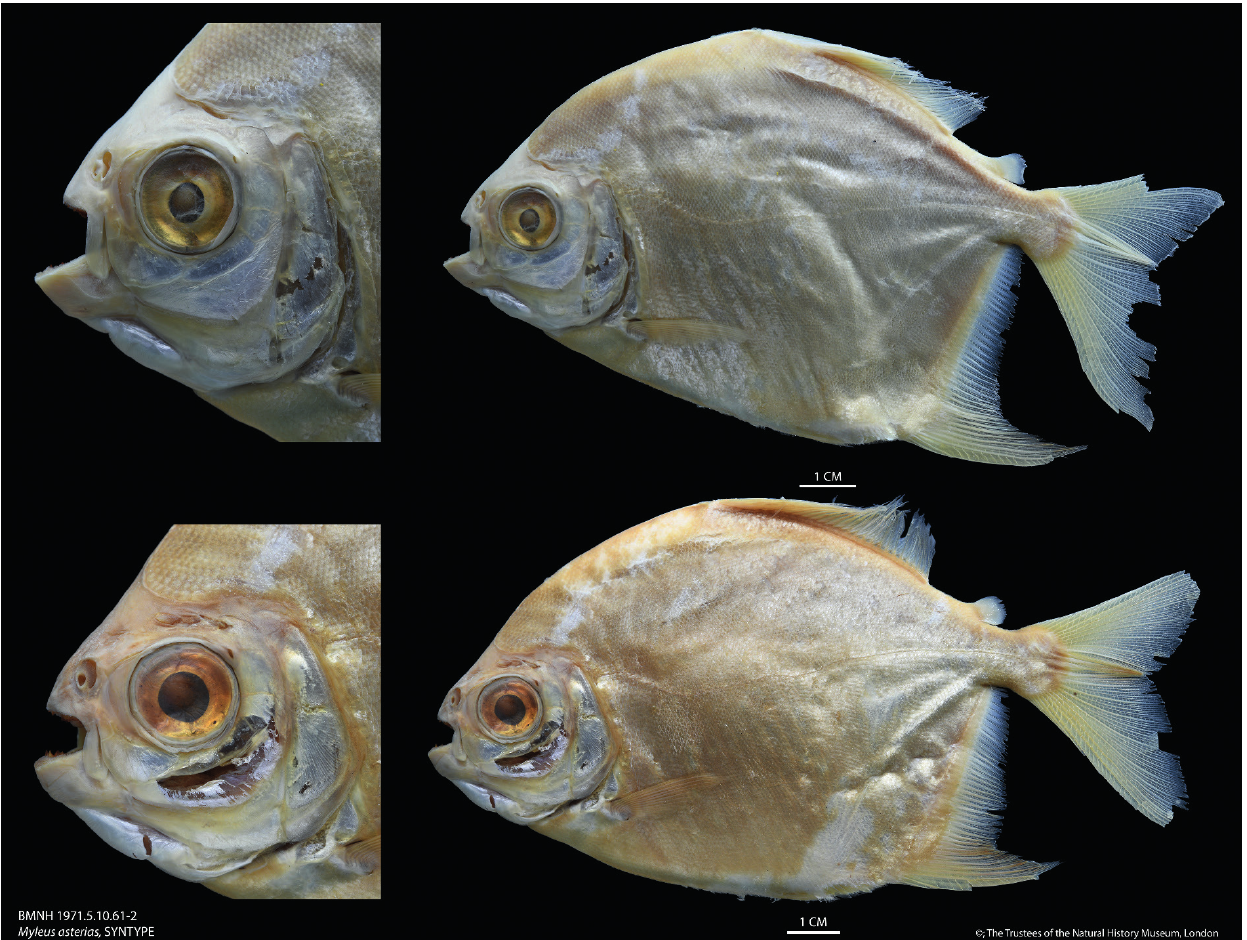
FIGURE 7 | Myleus asterias , paralectotypes, BMNH 1971.5.10.61-2, Essequibo River, Guyana. Photo: Kevin Webb. https://data.nhm.ac.uk/